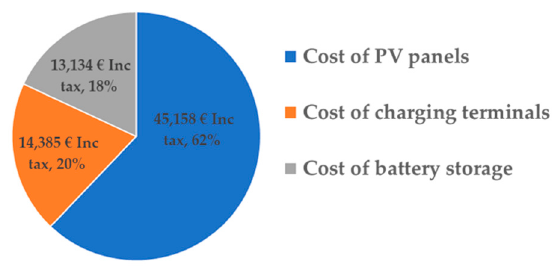
Figure 2. Distribution of the investment cost of the PVCS .